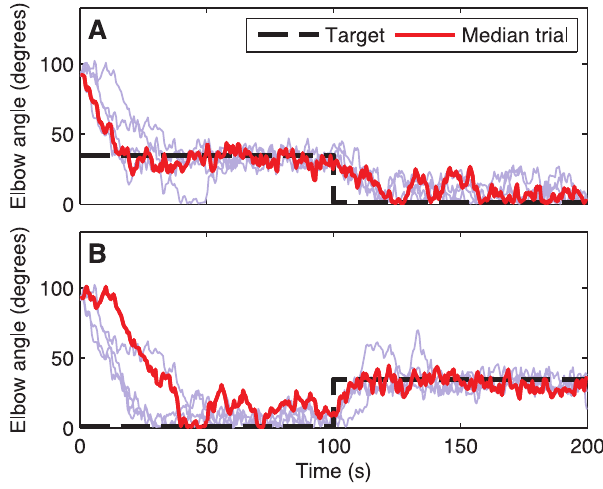
Figure 5. Serial target learning. A. 35 u 0 u . B. 0 u 35 u . (blue: 4 babble traces; red: median trial; wiring from Seed 1 of Fig. 4.).